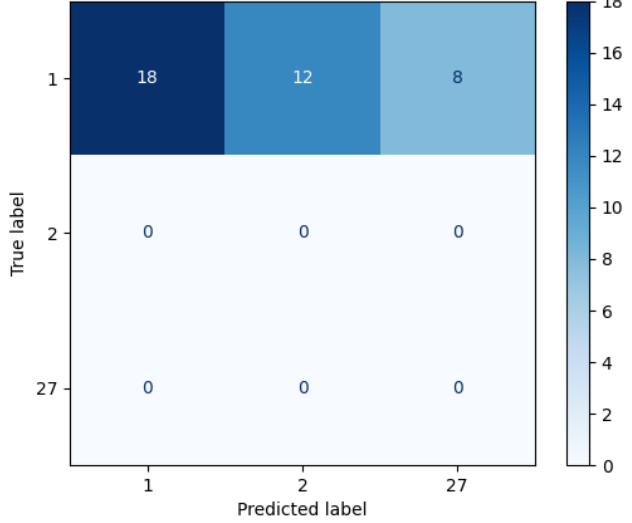
Figure 10. Example of confusion matrix obtained after the classification of layer 3.